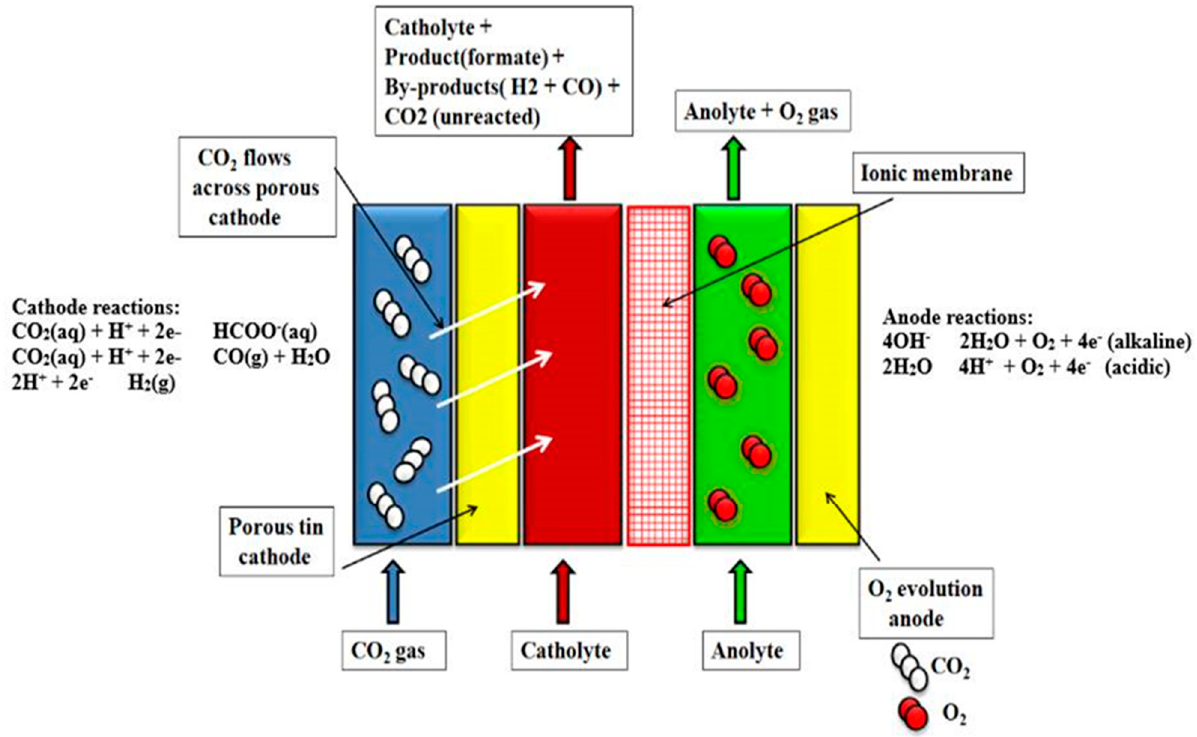
Figure 7. ECFORM electrolysis reactor.